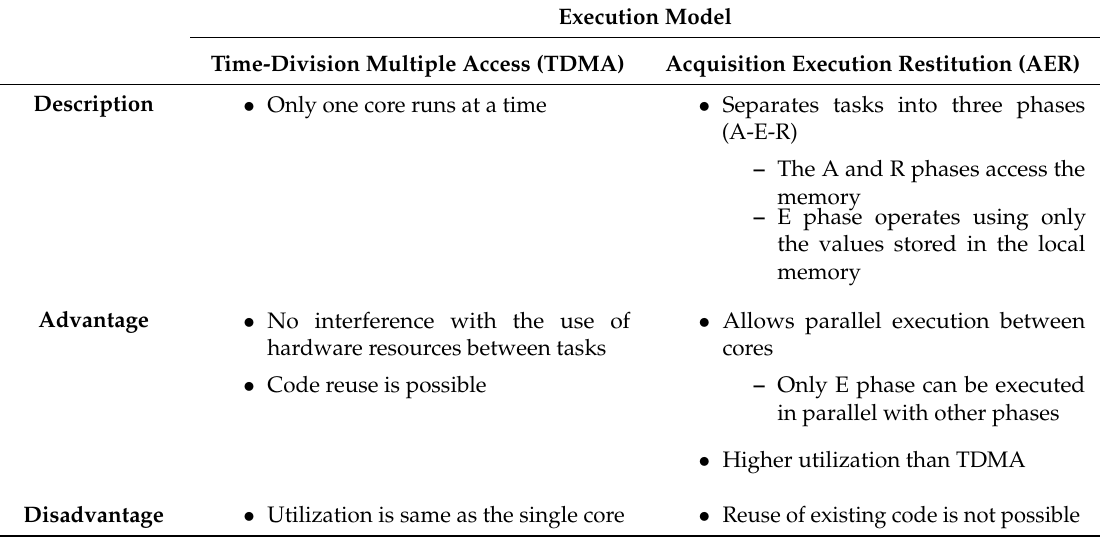
Figure 5. Major time frame comparison of TDMA and AER execution models. Table 1. Comparison of execution